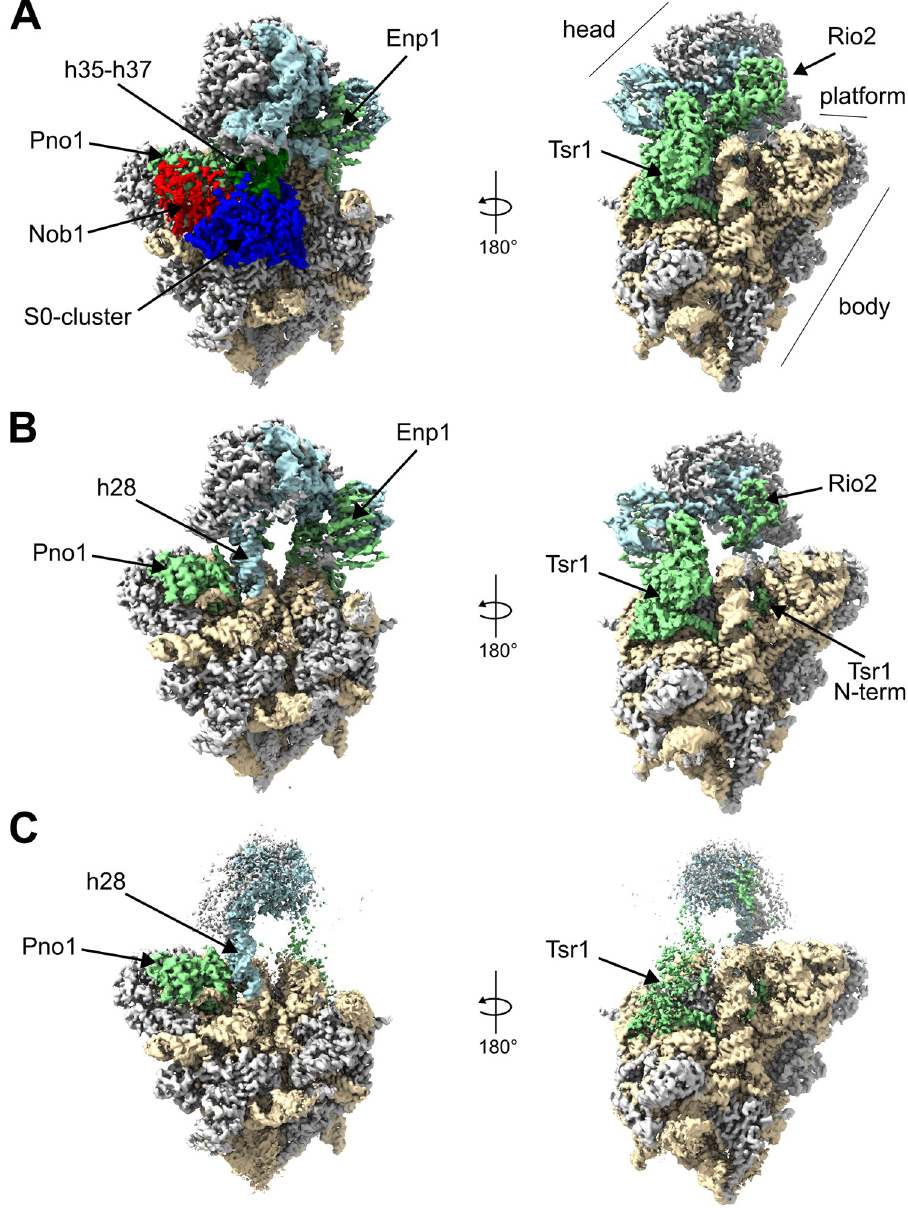
Fig 1. Cryo-EM derived maps of SSU precursor populations Enp1TAP_A (A), Enp1TAP-S21_A (B), and Slx9 TAP-S21_A (C). Helices h35-h37 are shown in dark green, other rRNA of the head in light blue, rRNA of the body in light brown, the S0-cluster in dark blue, Nob1 in red, and all other factors in light green, and r-proteins in gray.